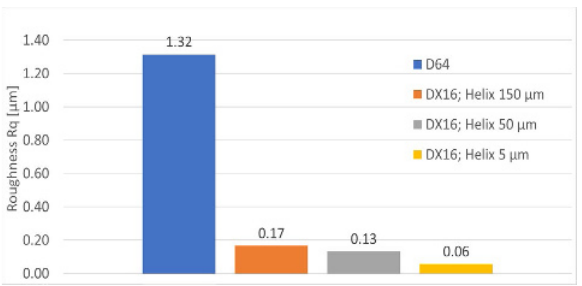
Fig. 4. Roughness results with different helical infeed depths at